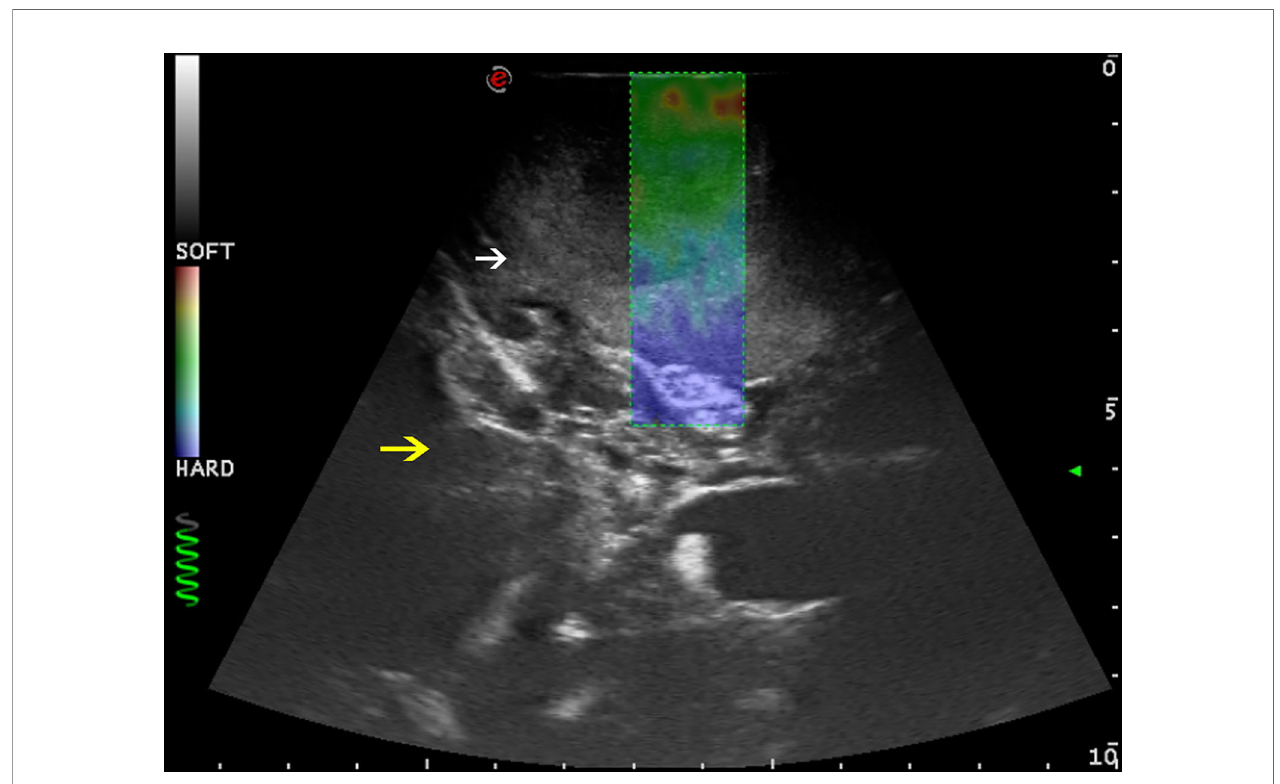
FIGURE 3 | Strain elastosonography frame in a case of right parietal GBM (case no. 3). Elastosonography gives information about the stiffness of the tissue, and it is revealed through a chromatic scale. Red spots are representative of softer zones (necrotic areas); blue spots are representative of harder zones (brain – tumor interface and brain parenchyma). The core of the lesions appears to be softer than surrounding normal brain parenchyma. White arrow: GBM. Yellow arrow: surrounding normal brain